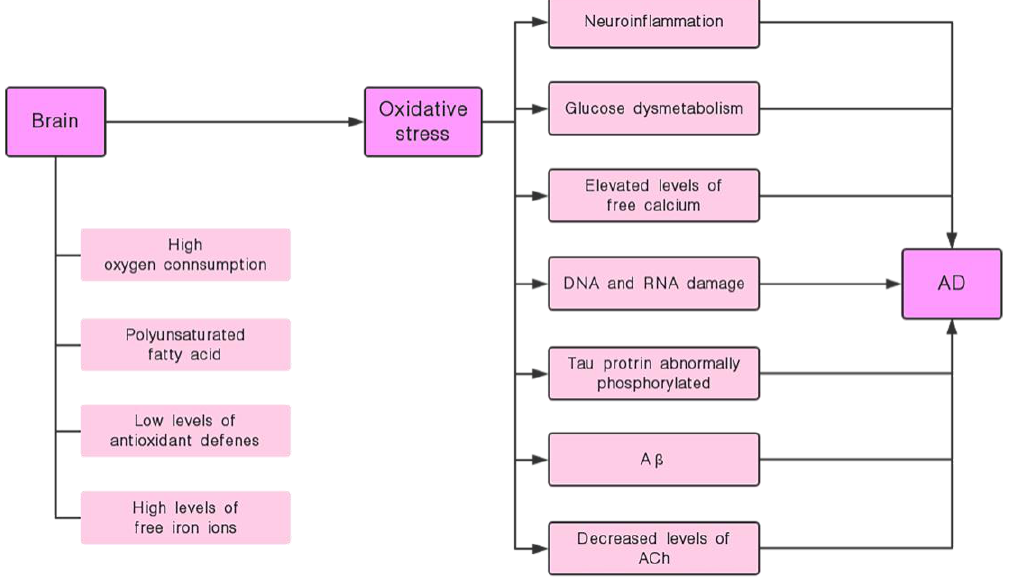
Figure 5. Cerebral oxidative stress leads to impairment of learning and memory.